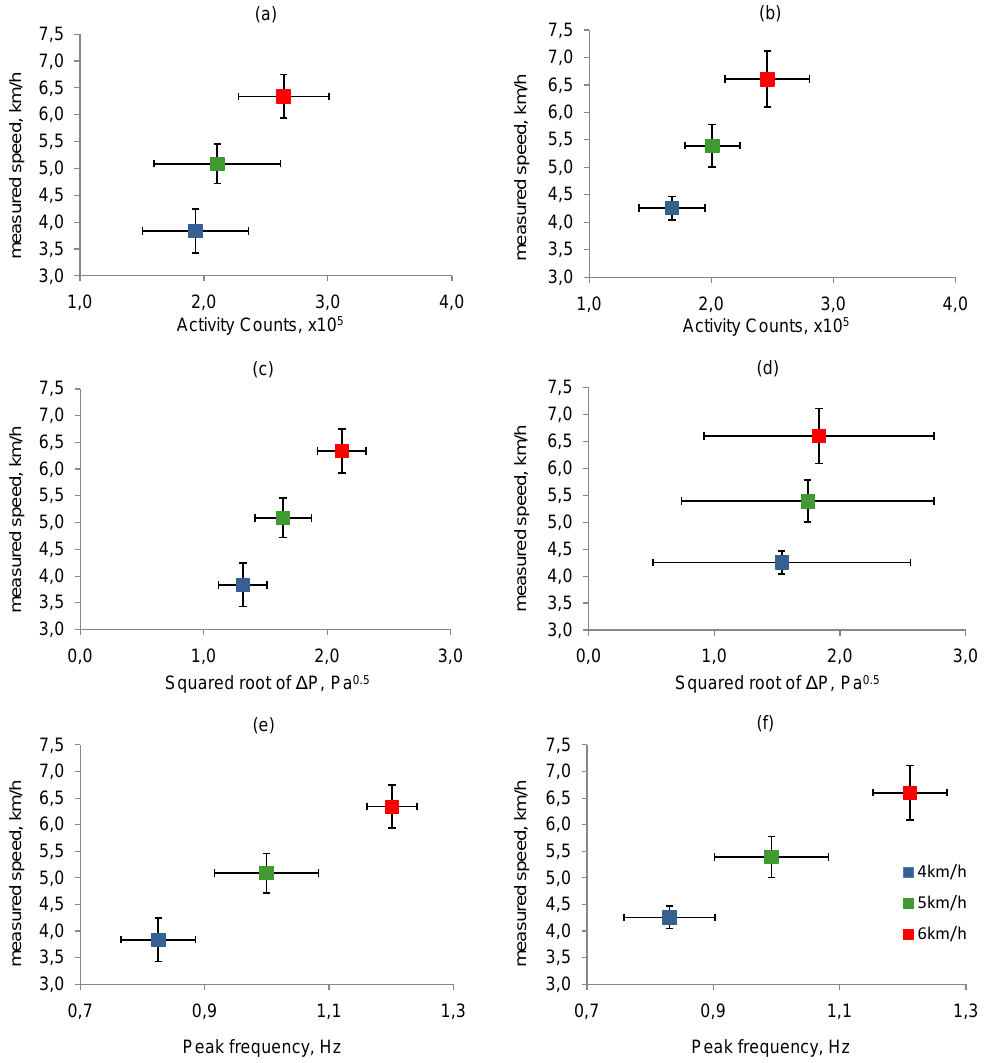
Figure 7. Representation of inter-individual variability in measured parameters indoors (a,c,e) and outdoors (b,d,f). Error bars indicate the standard deviation of the statistical